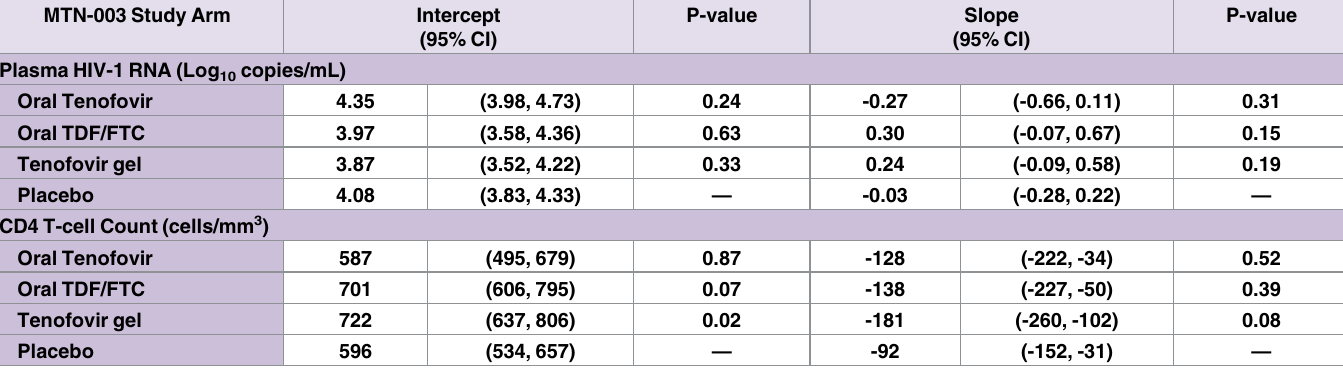
Table 2. Linear mixed effects model comparing HIV-1 RNA (log 10 ) and CD4 T-cell counts between the first result 90 days or more after the esti- mated HIV seroconversion date (intercept) and the 12-month visit (slope) by study arm. MTN-003 Study